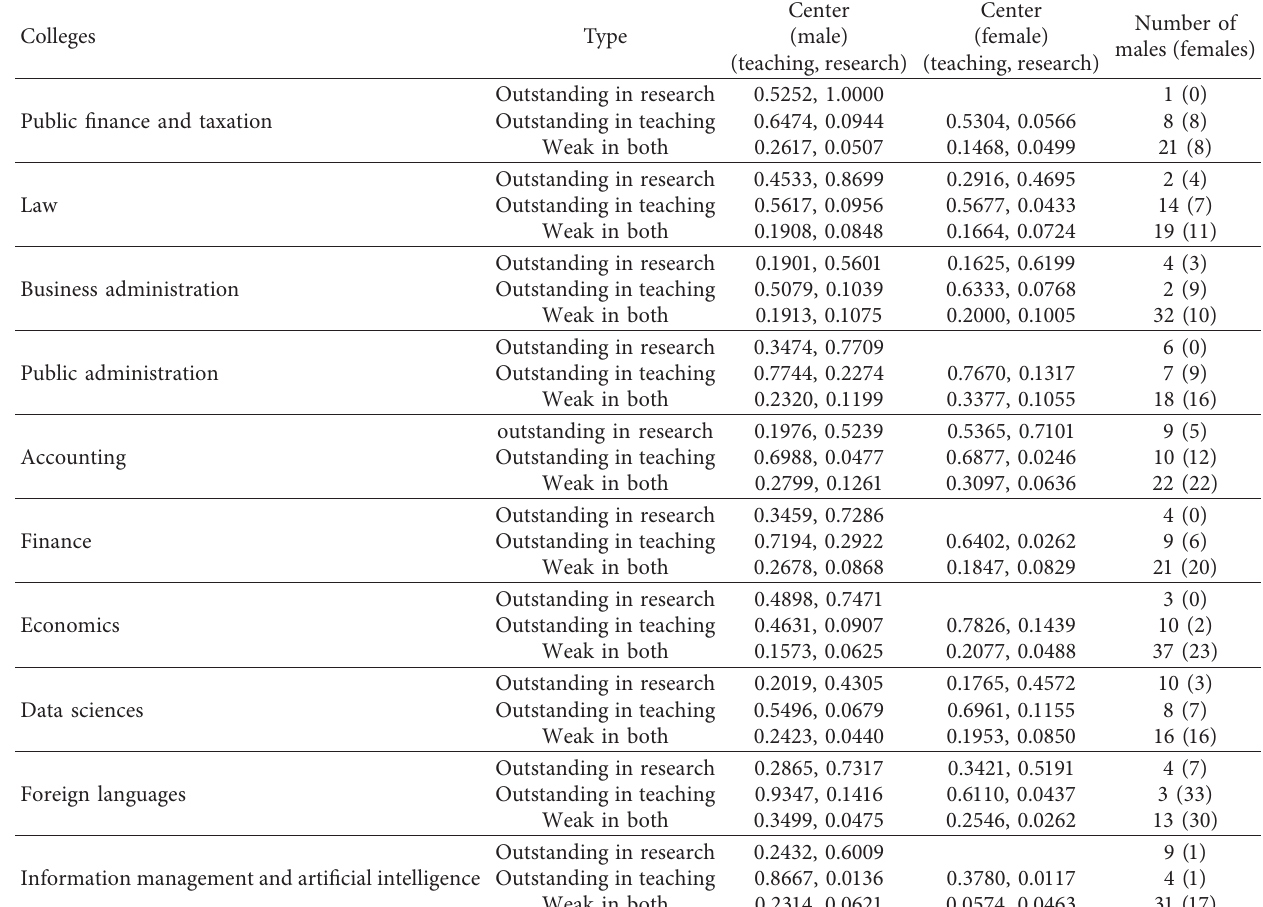
Table 3: Cluster analysis of teaching and research